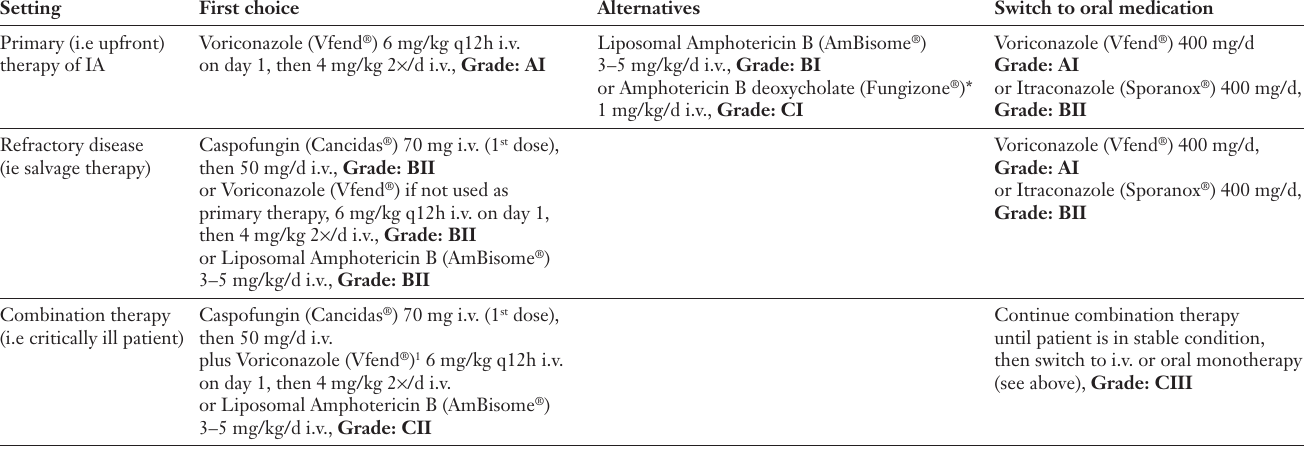
Treatment recommendations for invasive Setting